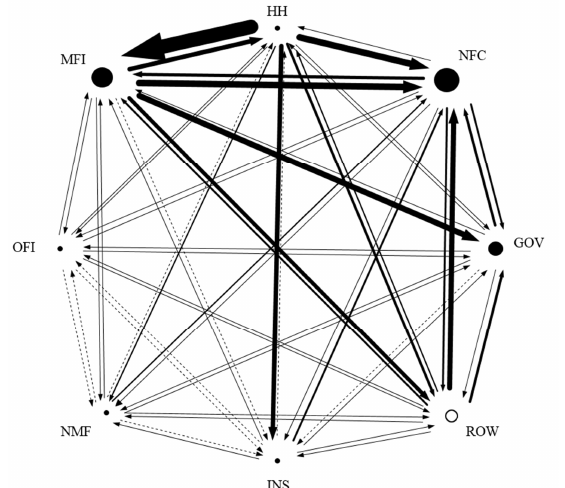
Figure 8. Increase in intersectoral financial flows induced by the increase in households’ net